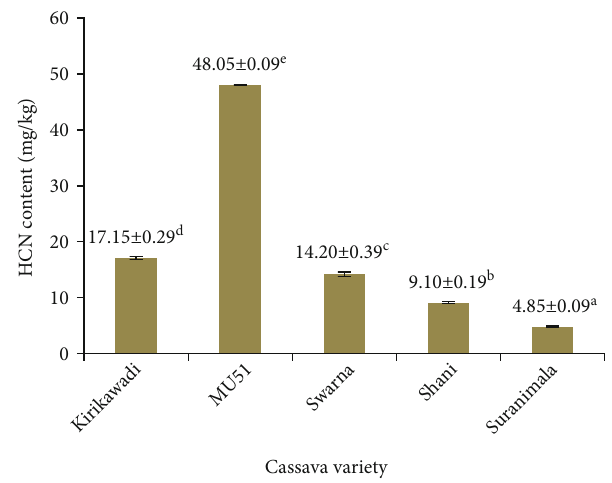
Figure 3: HCN content of cassava fl ours from fi ve Sri Lankan cassava varieties. Values are expressed as mean ± standard deviation of three independent determinations. Di ff erent superscripts represent signi fi cantly di ff erent samples ( p < 0 : 05